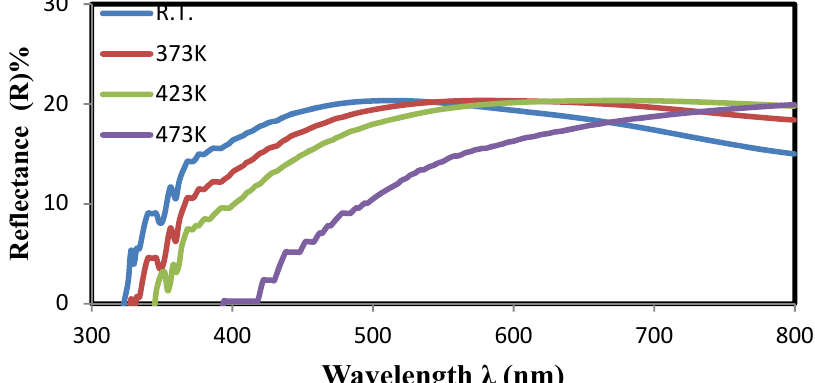
Cu thin films. 0.99 0.01